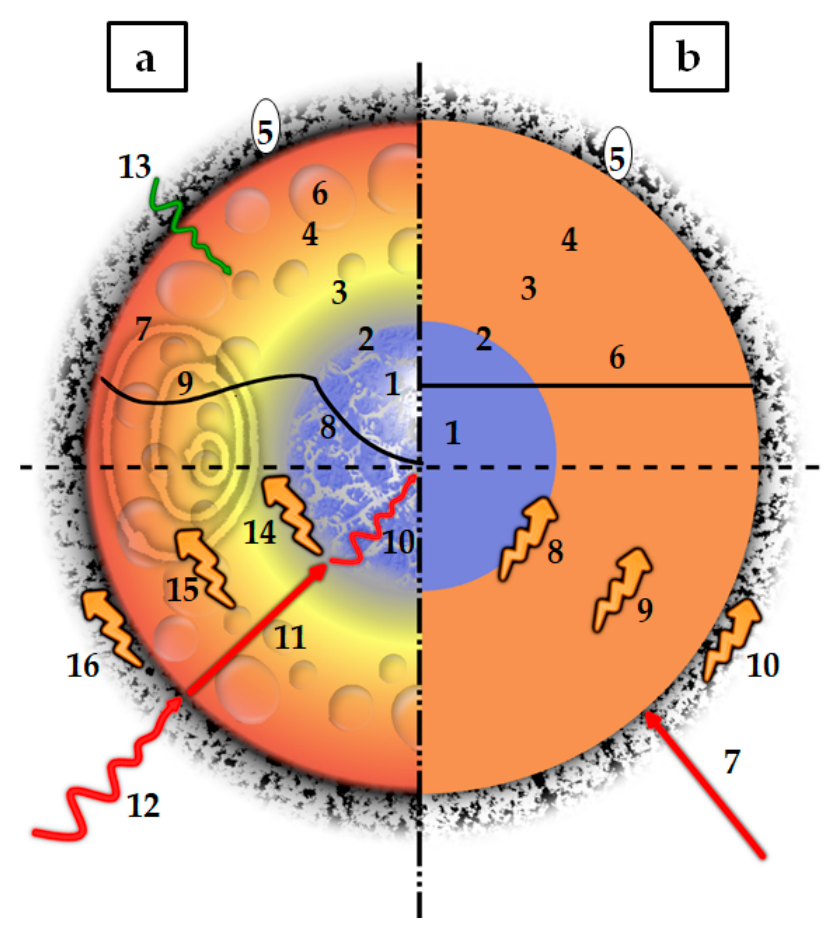
Figure 5. Simplified schematic of the sequential phenomena happening during the solid plastic pyrolysis and gasification (adapted from [38,51,52]); ( a ) Comprehensive modeling approach: (1) Porous solid plastic core; (2) Melt front; (3) Liquid layer; (4) Pyrolysis and evaporation (devolatilization) layer; (5) Gasification layer (including char); (6) Bubbles present in the liquid layer as the result of pyrolysis and evaporation; (7) Vortex-pattern flows as the result of Marangoni and convection effects; (8) Diffusive transport phenomena; (9) Possible temperature (or concentration) profile as the result of internal circulations in the liquid phase; (10) Internal radiative and conductive heat transfer; (11) Conductive and convective heat and mass transfer; (12) Radiation and convective heat and mass transfer; (13) Mass diffusion; (14) Heat of melting; (15) Heat of decomposition and evaporation; (16) Heat of gasification; ( b ) An example of a simplified approach: (1) Solid plastic core; (2) Sharp melt front; (3) Liquid layer; (4) Pyrolysis and evaporation (devolatilization) layer; (5) Gasification layer (including char); (6) Infinite internal heat and mass transfer; (7) Convective heat and mass transfer; (8) Heat of melting; (9) Heat of decomposition and evaporation; (10) Heat of gasification; A detailed description of each part is given throughout this review.